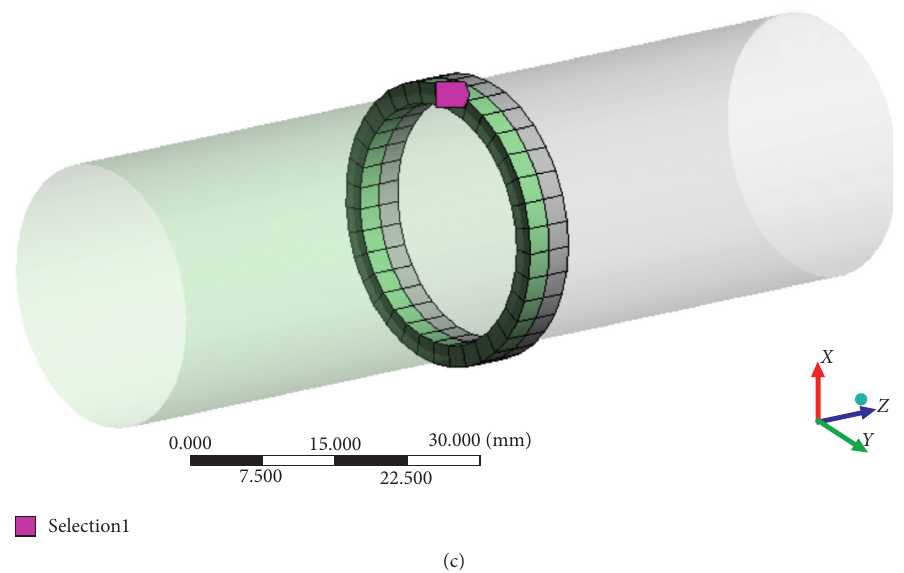
Figure 10: FEA process (a), rendering effect diagram of tension and torsion (b), and the elements of Selection 1 (c).